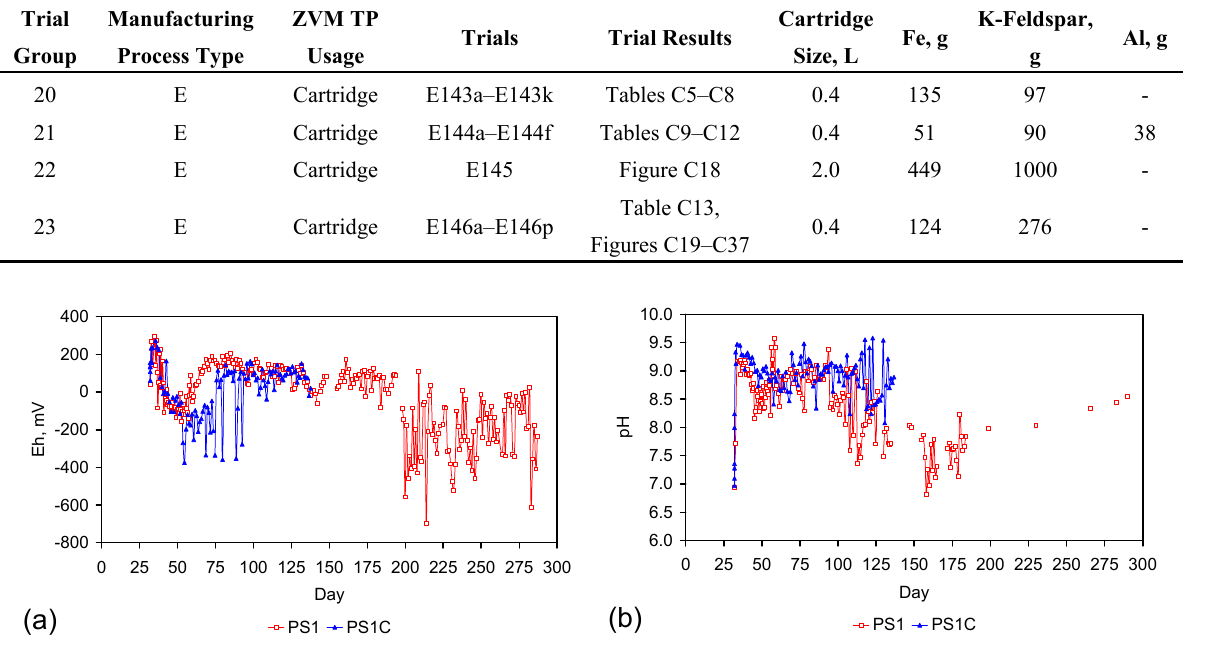
Table D3. ZVM molar compositional ratios used to manufacture ZVM TPA. K-Feldspar (11.3% K 2 O + 3.2% NaO + 18.5% Al 2 O + 65.8% SiO 2 ); Manufacturing Process Type E = dry mixing in air. Al = 5 mm